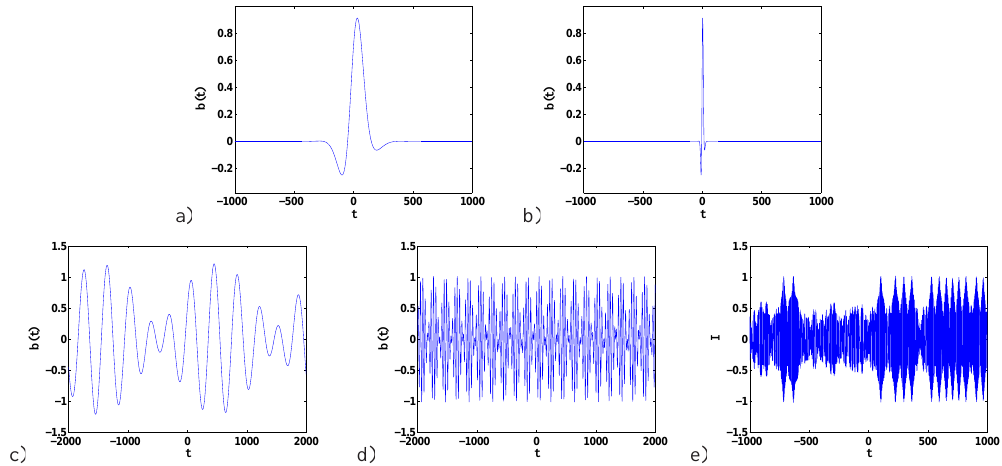
Fig. 3. Representation of different forcing functions b ( t ) in example (34). a) Forcing as in Eq. (36) for ε = 0 . 01 ; b) forcing as in Eq. (36) for ε = 0 . 1 ; c) Forcing as in Eq. (37) for ε = 0 . 01 ; d) forcing as in Eq. (37) for ε = 0 . 1 ; e) chaotic forcing.